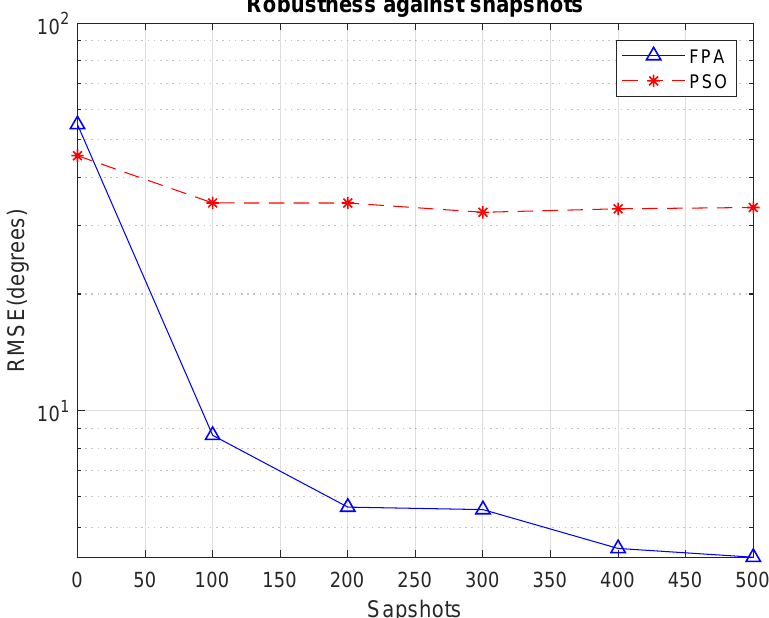
Figure 7. Robustness against snapshots for seven targets.